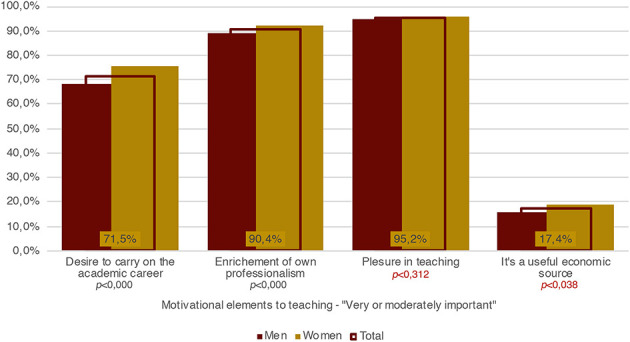
Motivational elements for teaching—“very or moderately important,” incidence by gender and total (Source: our survey).